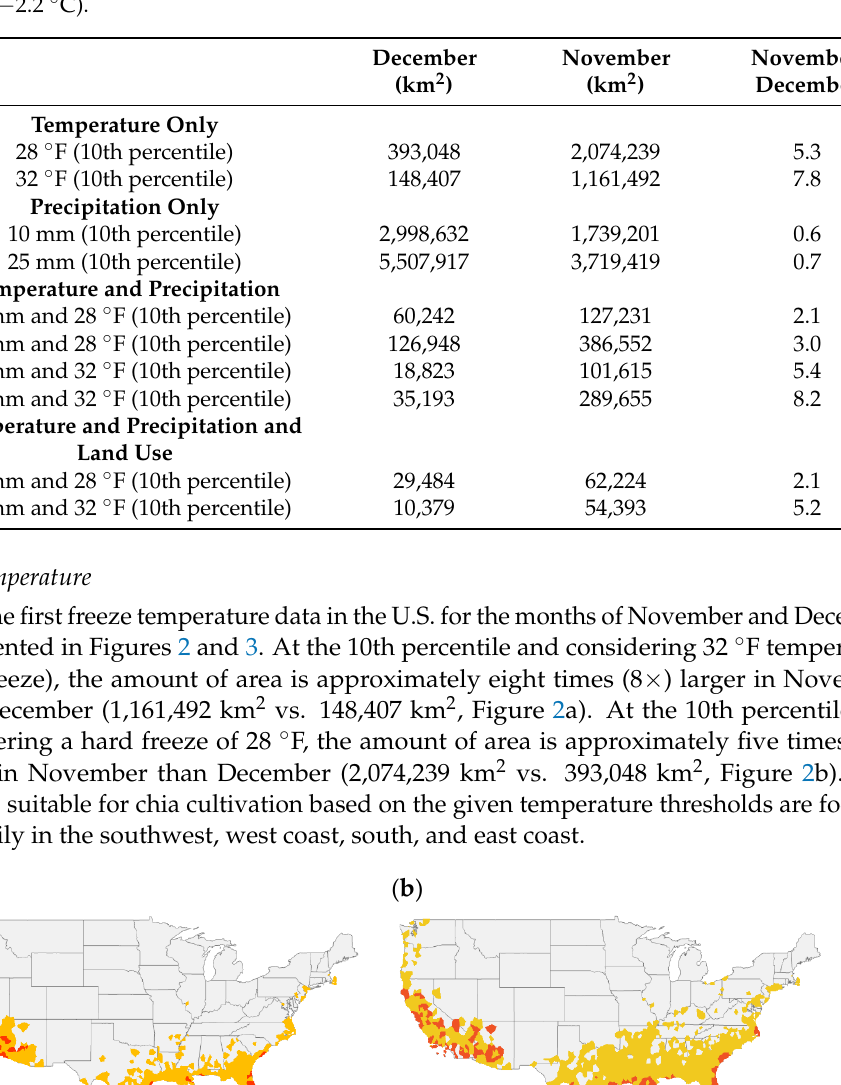
Table 2. Summary of all analyses presented in Figures 2–9. Results show the area in km 2 of the conti- nental United States that meet the temperature, precipitation, or land use criteria (note: 32 ◦ F = 0 ◦ C, 28 ◦ F = − 2.2 ◦ C).